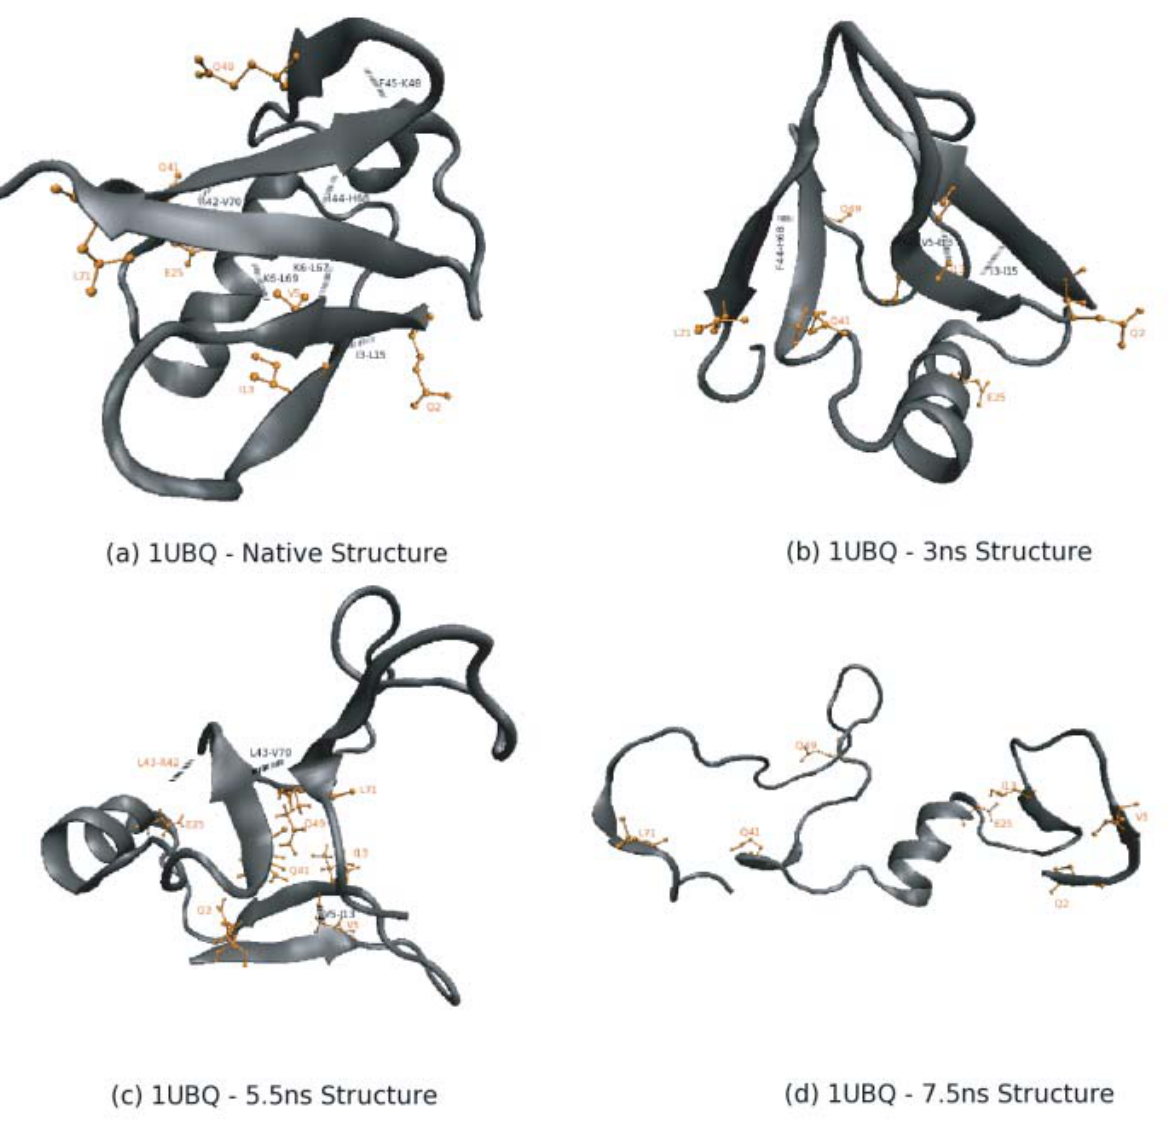
Figure 11. The figure shows the hydrogen bonds in the betasheet of ubiquitin along with the positions of seven of the top 11 HPZ residues (Q2,V5,I13,E25,Q41,Q49,L71). The seven residues are shown in orange. The hydrogen bonds are shown as black dashes with the partners in each hydrogen bond, identified. See text for more details on the comparison of the different structures.